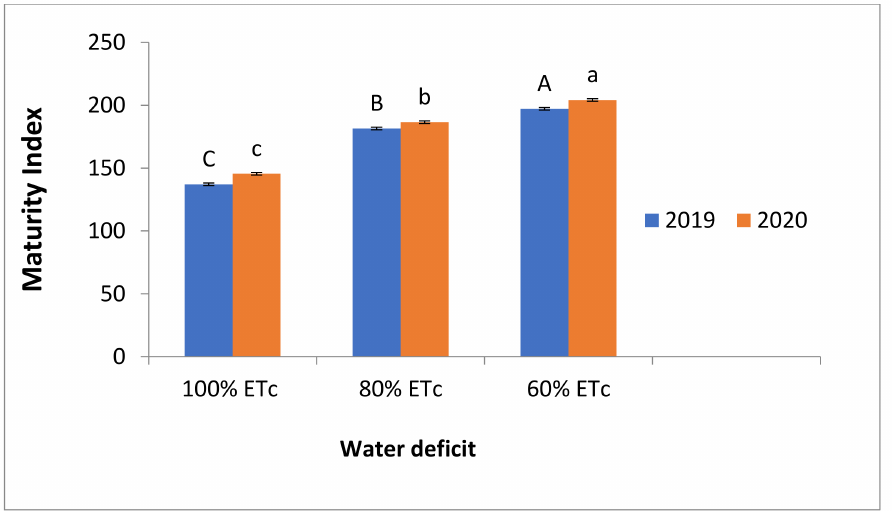
Figure 3. Effect of deficit irrigation (as a percentage of crop evapotranspiration, ETc) on maturity index of ‘African Rose’ plum fruit during the 2019 and 2020 seasons. Standard error bars and DMRT were used for mean comparisons within the same year ( n = 10). Capital and small letters represent DMRT for 2019 and 2020,